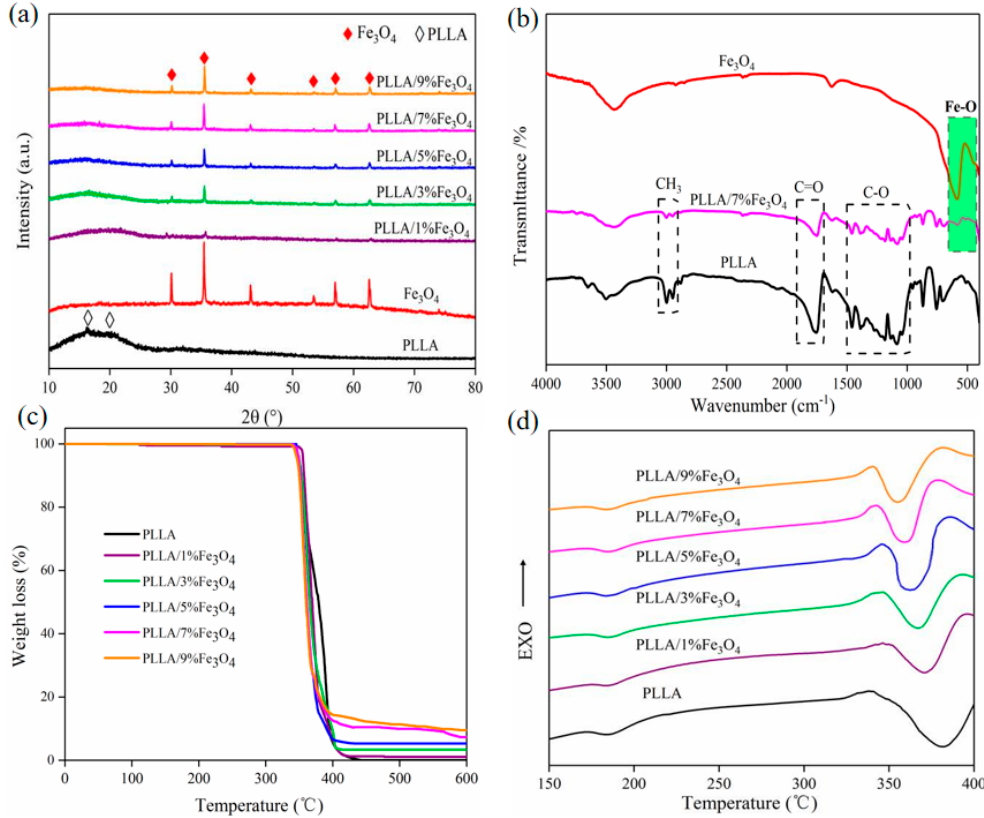
Figure 2. Physicochemical properties and thermal properties of the magnetic scaffolds with 0–9 wt % of Fe 3 O 4 content. ( a ) XRD patterns. ( b ) FTIR patterns. ( c ) TGA profiles. ( d ) DSC profiles.